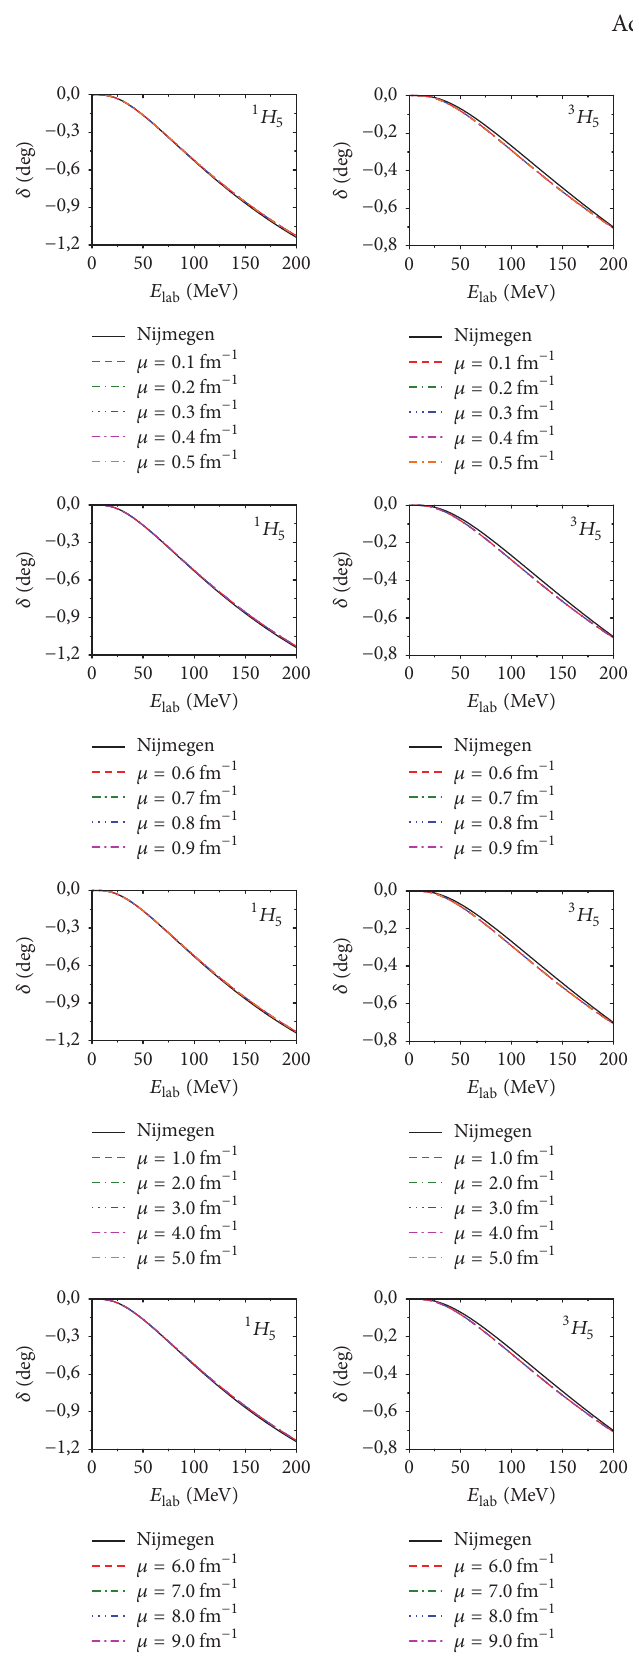
Figure 3: (Color on-line) phase shifts in 1 𝐻 5 and 3 𝐻 5 uncoupled channels calculated from the solution of the subtracted LS equation for the 𝐾 -matrix with five subtractions for the N3LO-EM potential for several values of the renormalization scale compared to the Nijmegen partial wave